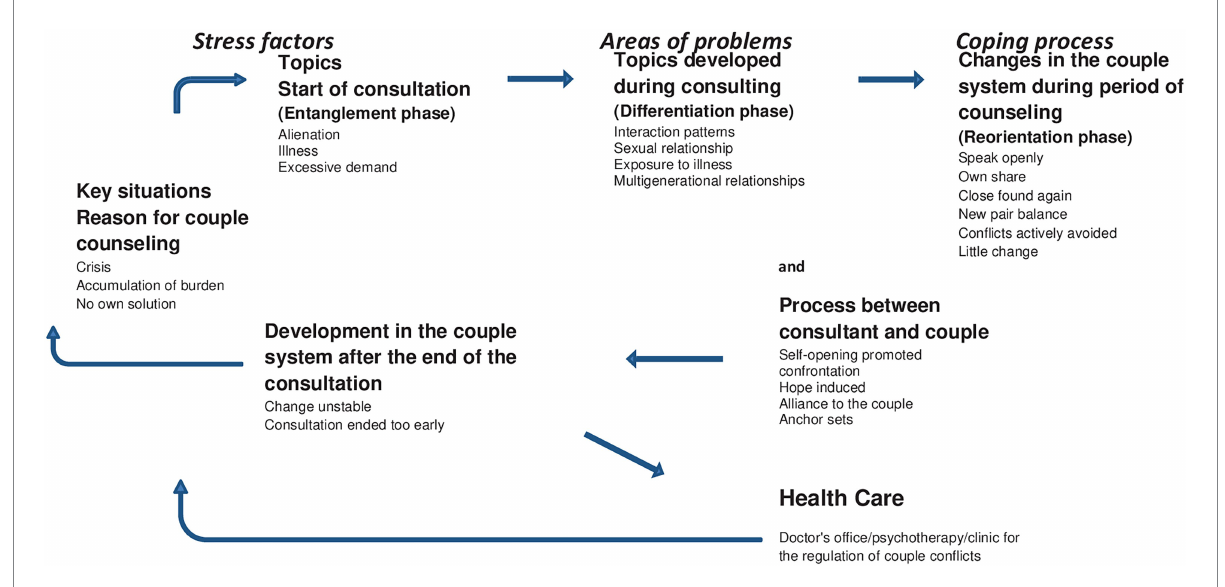
FIGURE 2 Long-term couple relationships-stress, problems and coping processes in couple counseling: A circular process model.